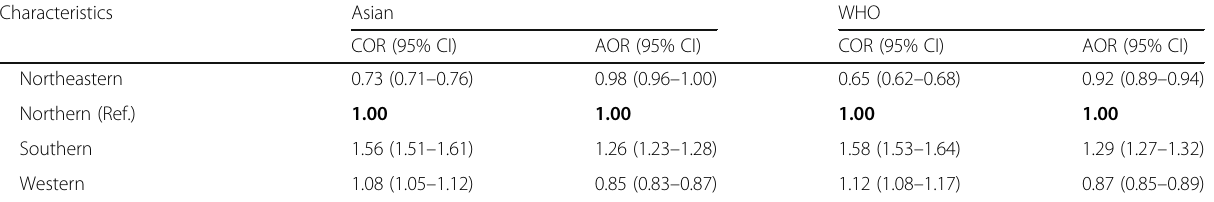
1. Asian and WHO classifications categorize overweight/obesity as BMI ≥ 23 and ≥ 25 Kg/m 2 , respectively 2. The p values were below <0.05 when the 95% confidence interval did not include 1 AOR Adjusted odds ratio, COR Crude odds ratio, CI Confidence interval, WHO World Health Organization : p <0.05,: p <0.01,: p